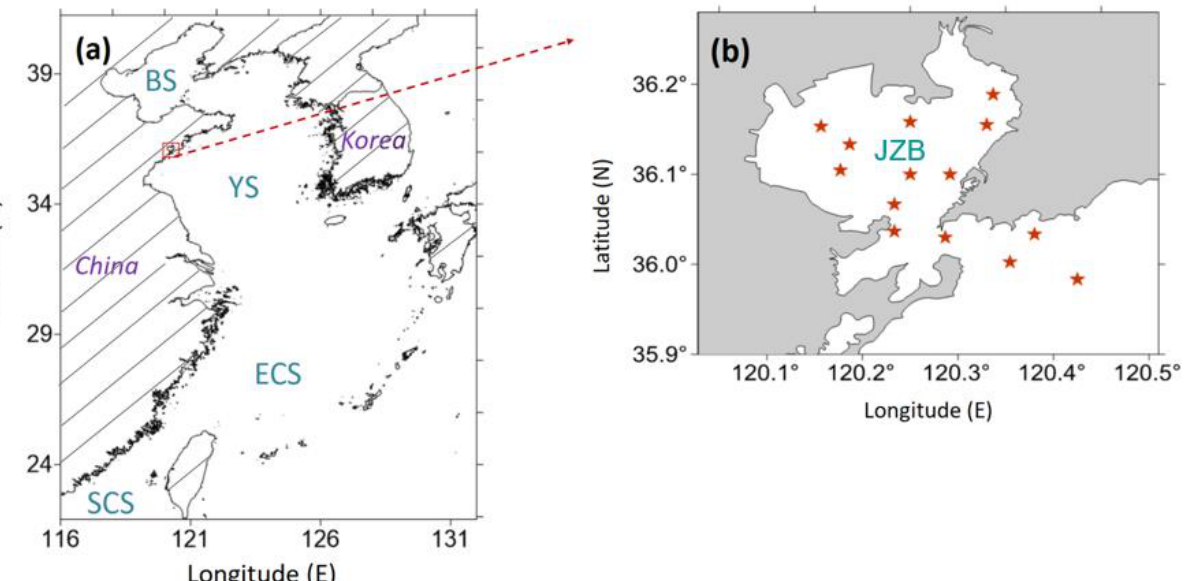
Figure 1. Location and sampling stations of the Jiaozhou Bay. ( a ). SCC, the South China Sea; ECS, the East China Sea; YS, the Yellow Sea; BS, the Bohai Sea. ( b ) JZB, the Jiaozhou Bay. ‘ ★ ‘ represents the 14 stations with zooplankton sampling and environmental measurements for each month during